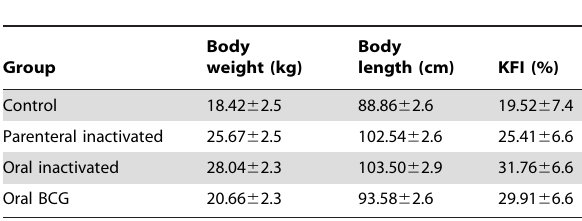
Table 1. Body weight, head and body length, and kidney fat index (KFI) at necropsy for wild boar belonging to four experimental groups (mean 6